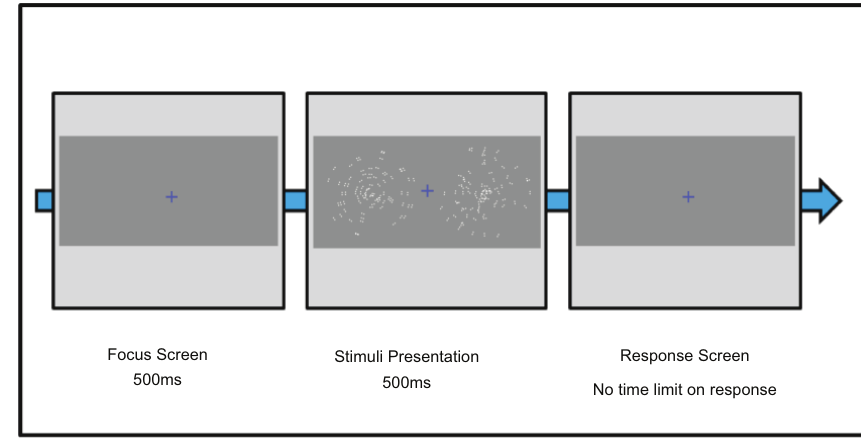
Figure 1. Pictorial representation of the dynamic Glass pattern (dGP) experiment